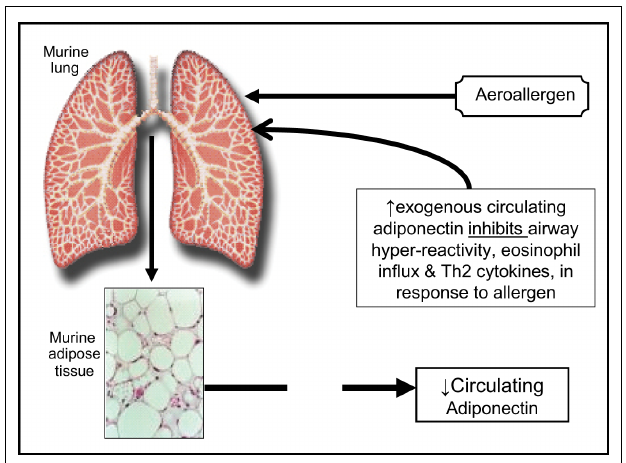
FIGURE 1 |A schematic representation of the suggested role of adiponectin in murine asthma, based on work by Shore et al.